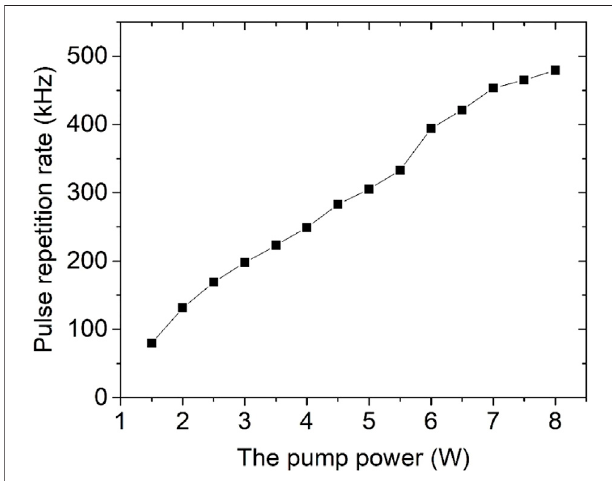
FIGURE 7 | Pulse repetition rate versus the pump power for SnSe 2 singly Q-switched